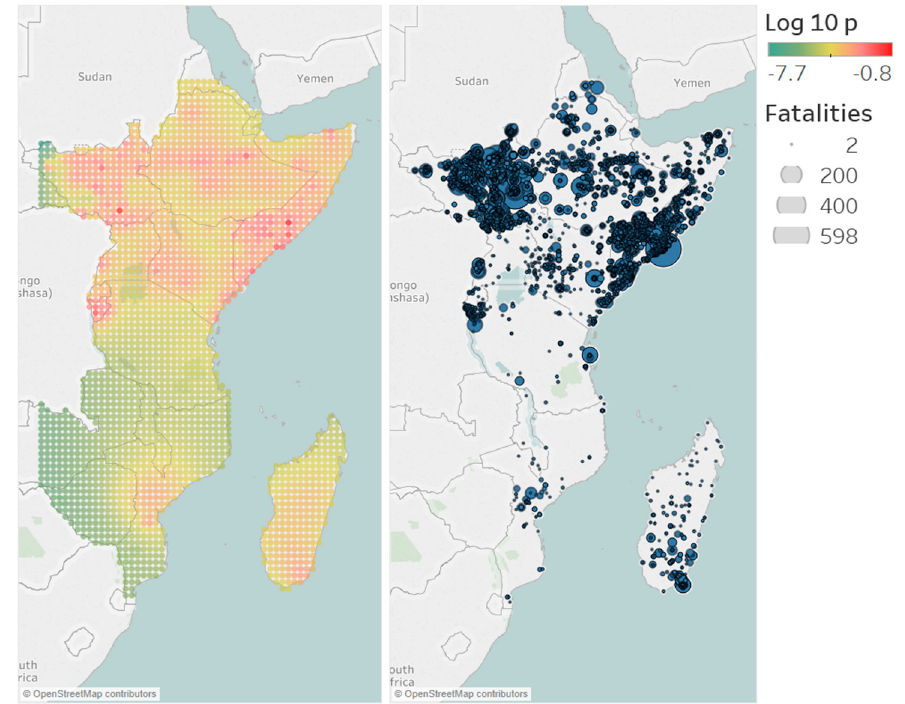
Figure 9. Spatial background distributions of the model with the largest log-likelihood for the region East Africa. The area is divided into N c = 4368 cells. In these cells, the background intensity is assumed to be homogeneous. The cells give the probability of a background event occurring in that cell.